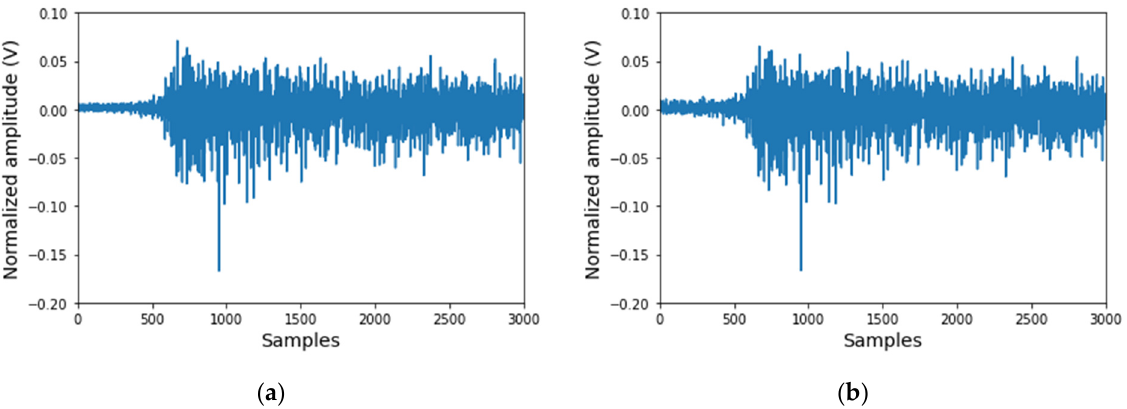
Figure 2. Representative ( a ) EMG signal, ( b ) augmentation signal using additive noise of “sEMG for Basic Hand movements Data Set”.